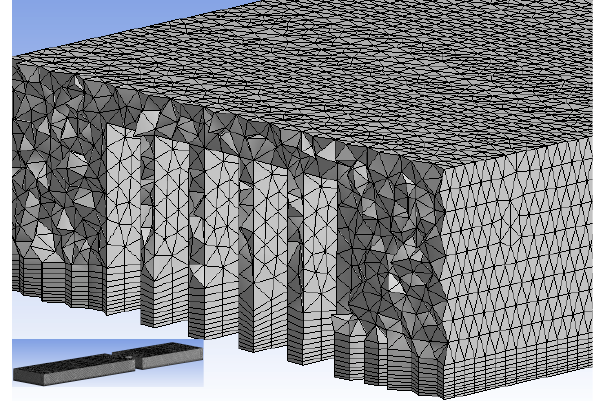
Fig. 4. Unstructured tetrahedral mesh with refinement